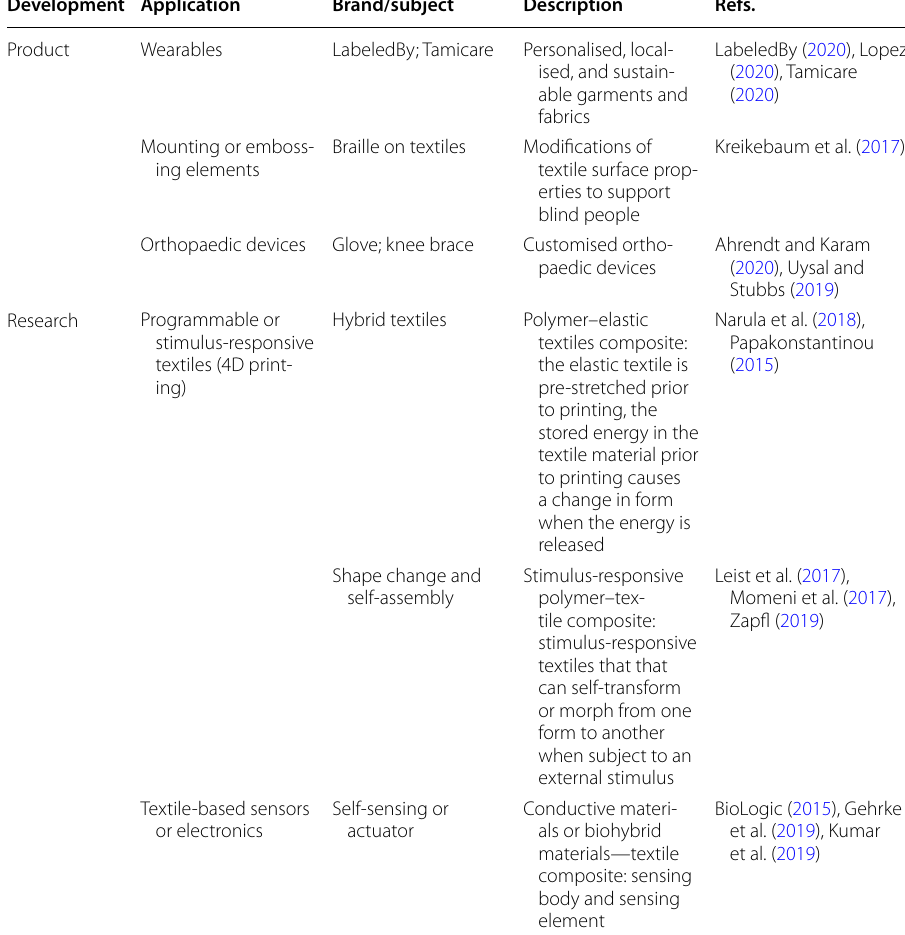
Table 1 Examples of applications and future research direction for ME polymer–textile